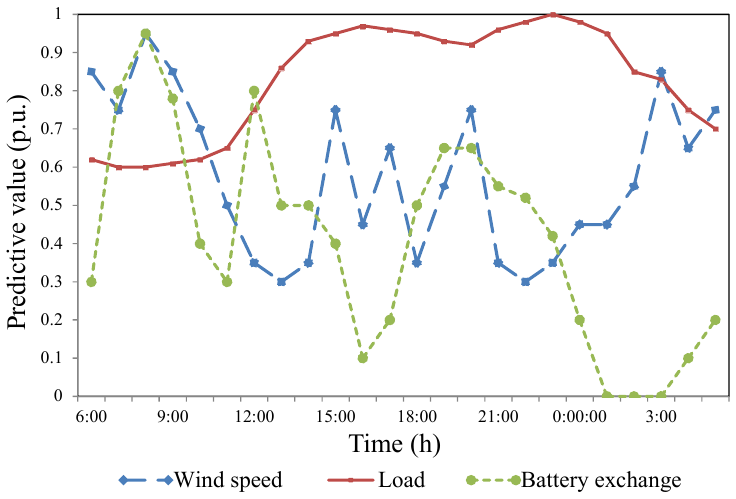
Figure 4. Power demand and wind farm output